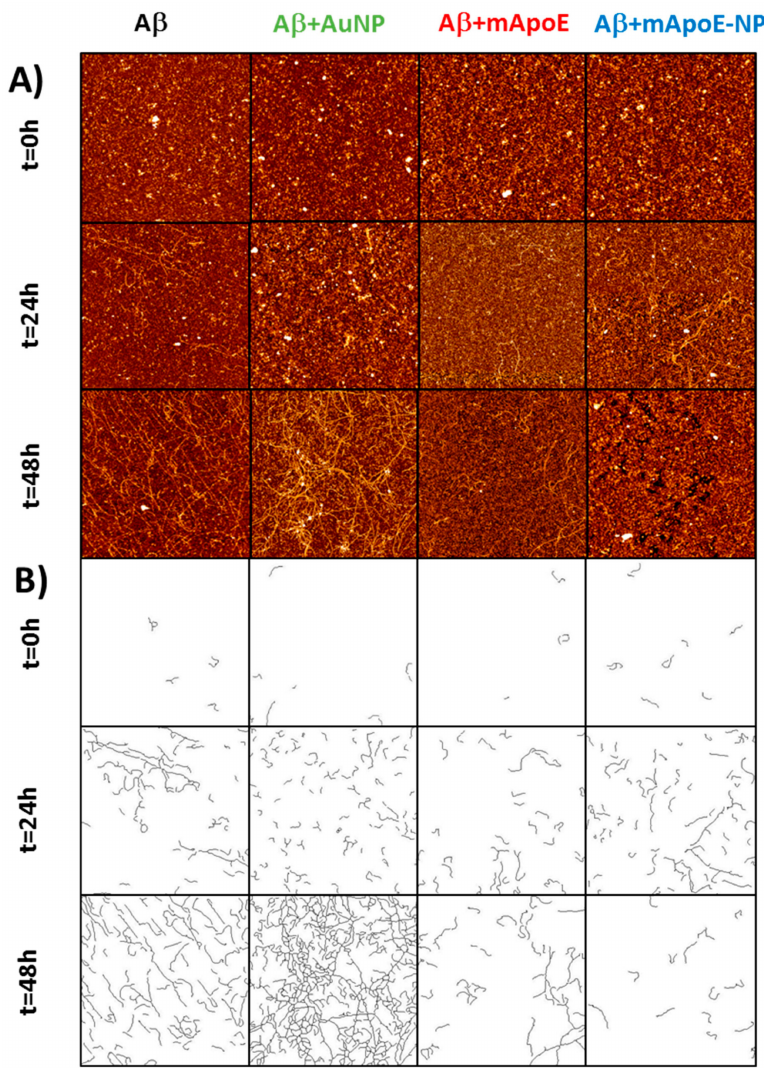
Figure 3. AFM imaging relative to the e ff ect of external chemical agents (bare NP, free mApoE, and AuNP coated with mApoE) on the fibrillar aggregation of A β 1-42. ( A ) Representative AFM images of typical aggregation patterns of bare A β 1-42 amyloid fibrils (first column), of A β 1-42 amyloid fibrils in presence of AuNP (second column), or free mApoE (third column), or AuNP coated with mApoE (fourth column). Data taken after incubation at 37 ◦ C, at three di ff erent incubation times: t = 0 h (first line), t = 24 h (second line), and t = 48 h (third line). Images of 4 × 4 µ m 2 , 1024 × 1024 pixel, Z-scale 10 nm. ( B ) Post-processed analysis of the AFM images reported in panel ( A ). The lines represent the resulting deposited fibrils as selected by the software procedure indicated in the Materials and